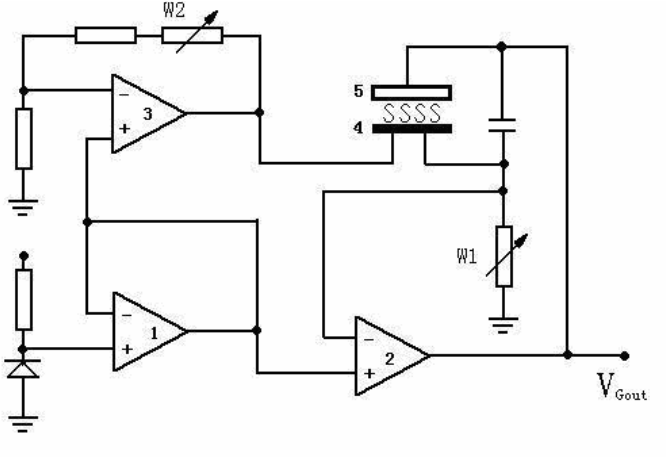
Figure 2. Determination principle of ISFET.